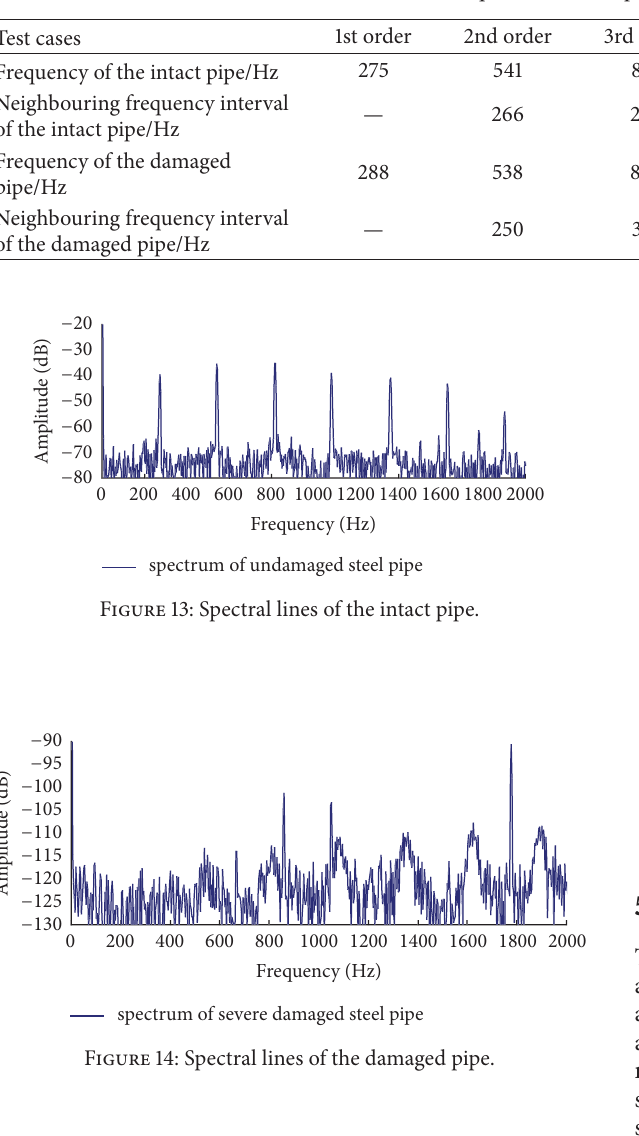
Table 2: Natural frequencies of steel pipes under various damage cases.